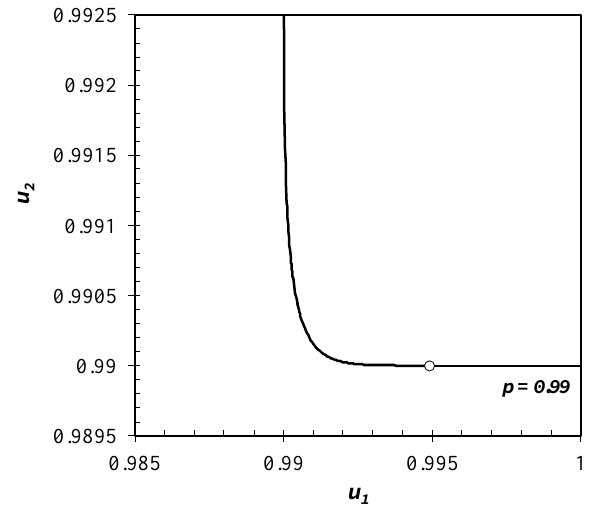
Figure 18. Flood design hydrograph corresponding to a JRP = 100